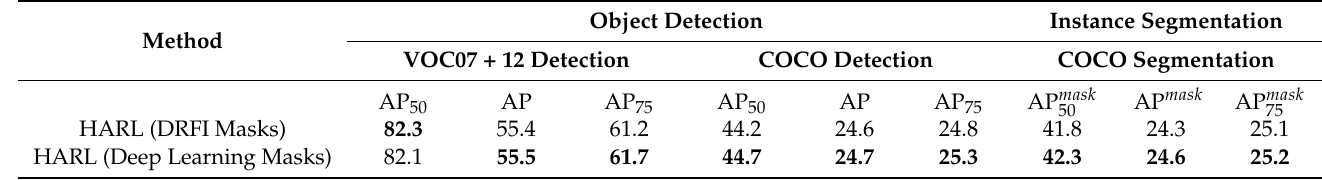
Figure 8. The inspection examples of the generated heuristic binary masks between DRFI and deep learning. Table 5. The impact of mask quality on HARL framework performance on the downstream object detection and instance segmentation task. We use Faster R-CNN with C4 backbone for object detection and Mask-RCNN with FPN backbone for instance segmentation. Object detection and instance segmentation backbones are initialized with the 100-epoch pre-trained ResNet-50 backbone on ImageNet dataset. The best result is